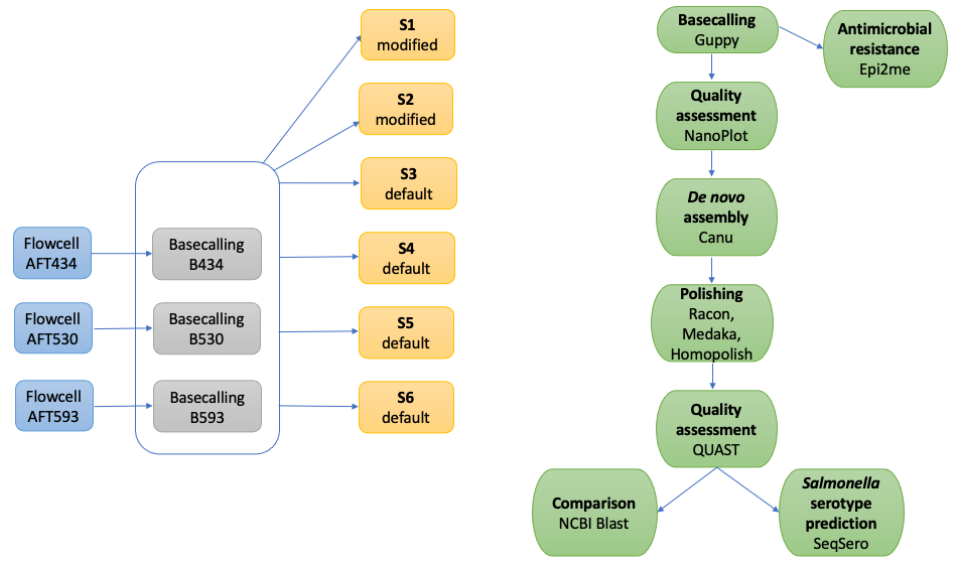
Figure 1. Workflow of the bioinformatic analysis performed.